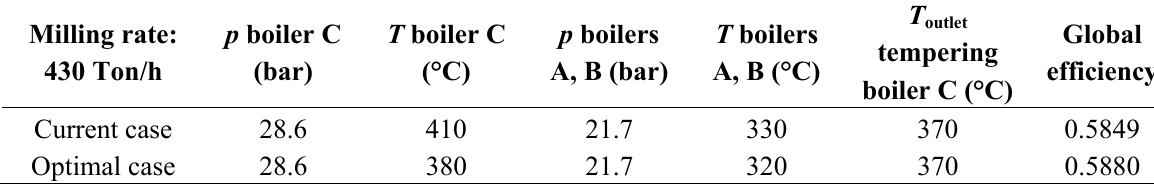
Table 4. Current and optimal case comparison considering real